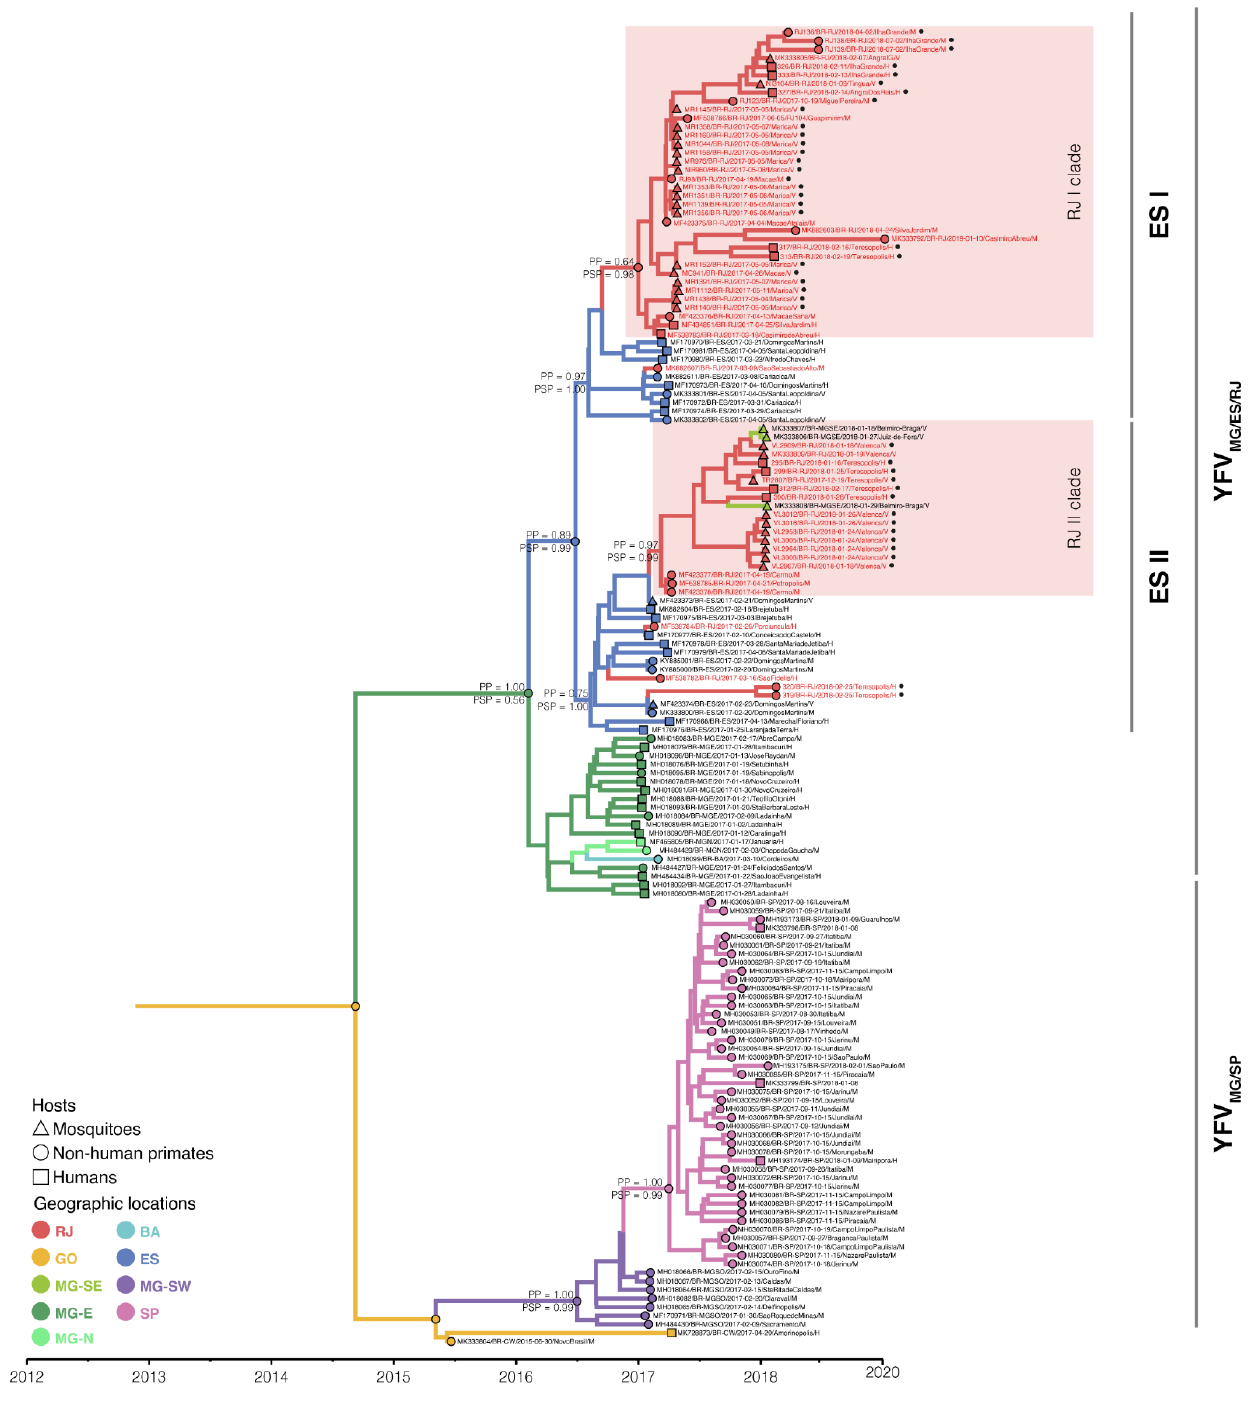
Figure 2. Time-scaled maximum clade credibility phylogeny of the YFVMG/ES/RJ lineage. The branches’ colors represent the most probable locations of their descendent nodes, as indicated in the legend. Tips names were codified as accession number/date/region/host, and tip symbols indicate the host as indicated in the legend. The tip labels corresponding to the data set of this study, 43 RJ YFV samples sequenced in this study (black dots in front of sequence names), and 16 RJ YFV from the GenBank database are colored red. All horizontal branch lengths are drawn to a scale of years. The location refers to Brazilian (BR-) following the state or region of the country: RJ, Rio de Janeiro; CW, central-western; BA, Bahia; MG-SE, southeastern Minas Gerais; MG-N, northern Minas Gerais; MG-E, eastern Minas Gerais; ES, Espírito Santo; MG-SO, southwest Minas Gerais; SP, São Paulo.